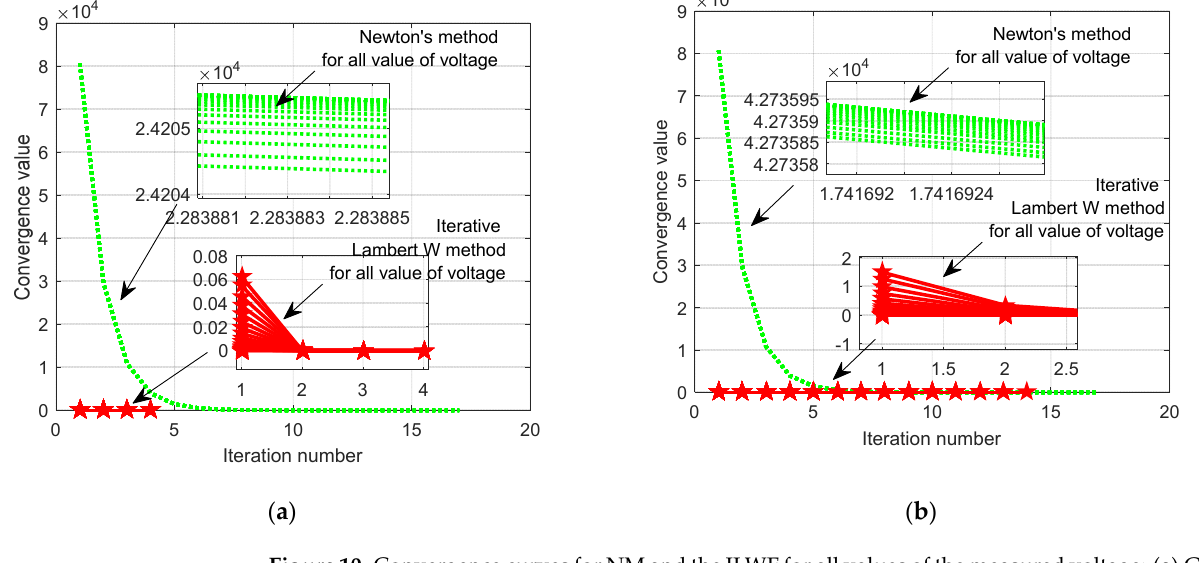
Figure 10. Convergence curves for NM and the ILWF for all values of the measured voltage: ( a ) Case 1; ( b ) Case 2.